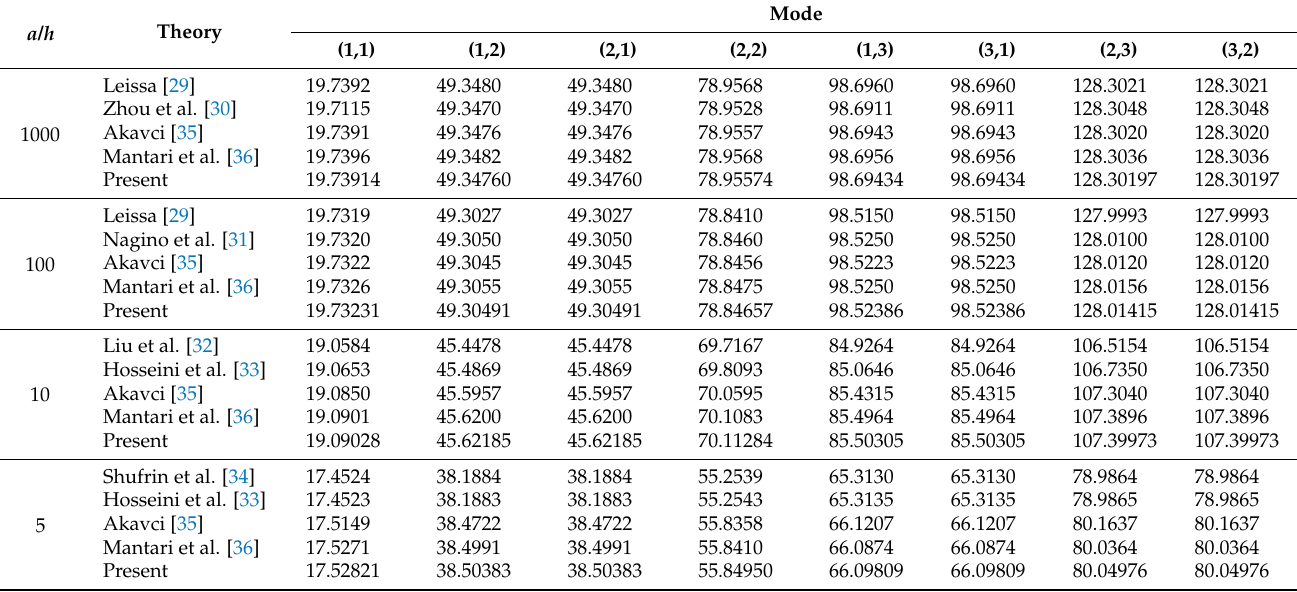
Table 1. Non-dimensional natural frequencies ω = ω a 2